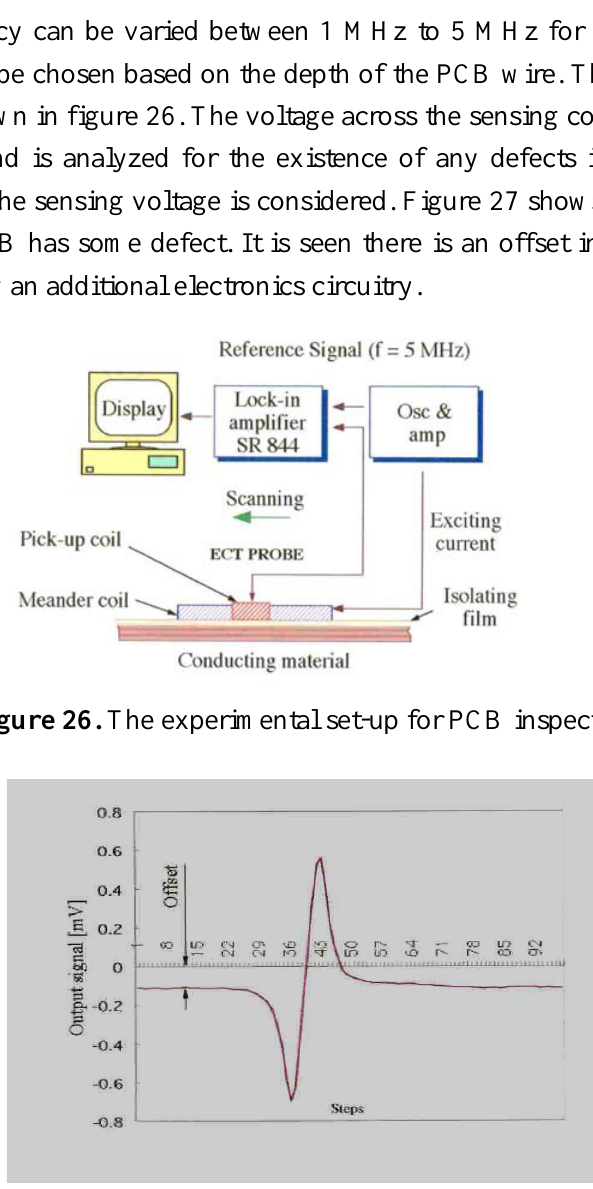
Figure 25. The target PCB (PCB of Pentium processor).